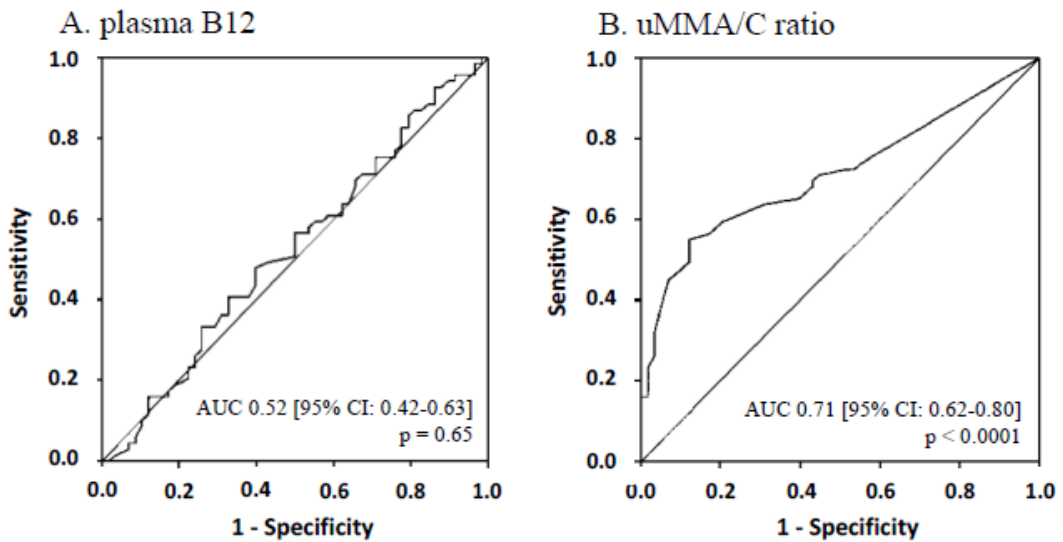
Figure 3. ROC curves and AUC of plasma B12 ( A ) and urinary methylmalonic acid to creatinine ratio ( B ) for the whole population.